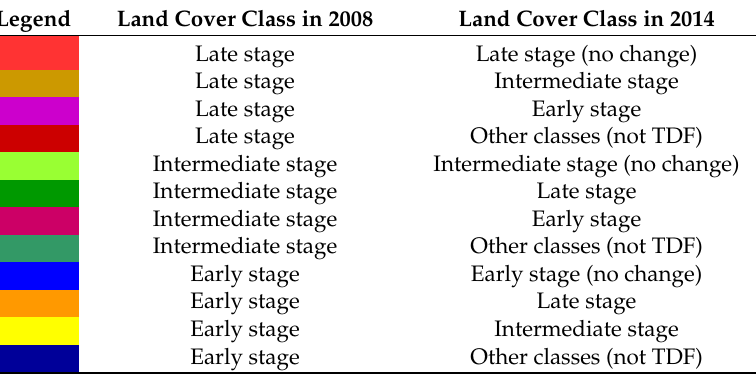
Table 4. Description of change detection